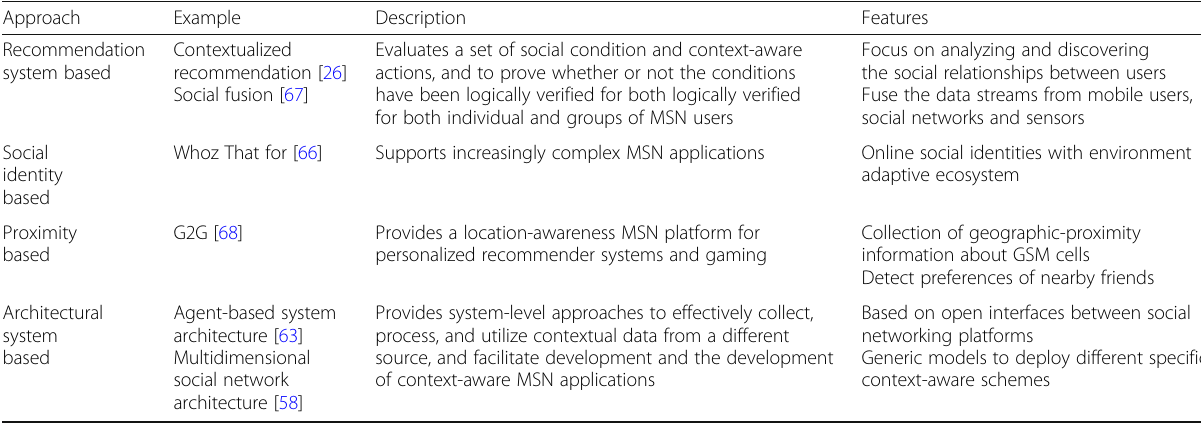
Table 2 Various architectures in MSN